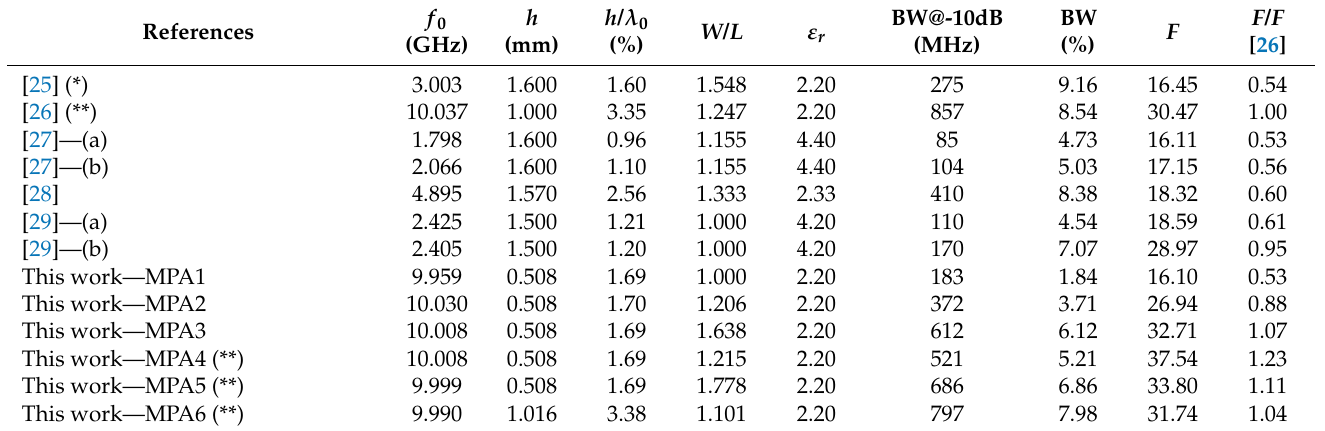
Table 5. Comparison between microstrip patch antenna